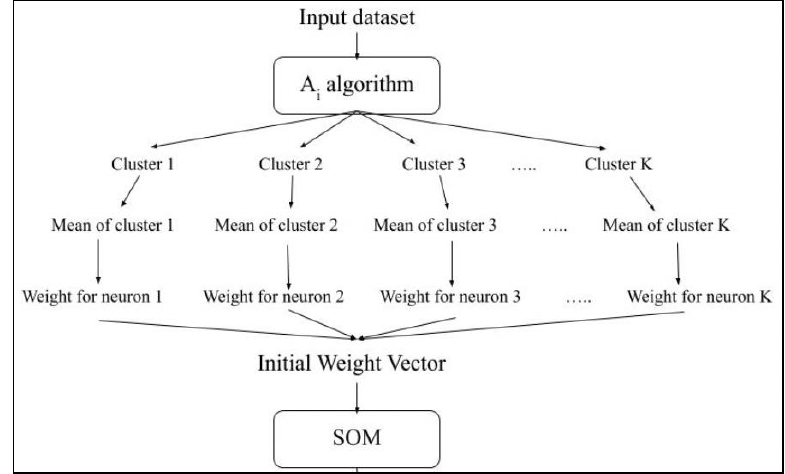
Figure 1. The first stage in the Multi-level Clustering Algorithm (MCOD).